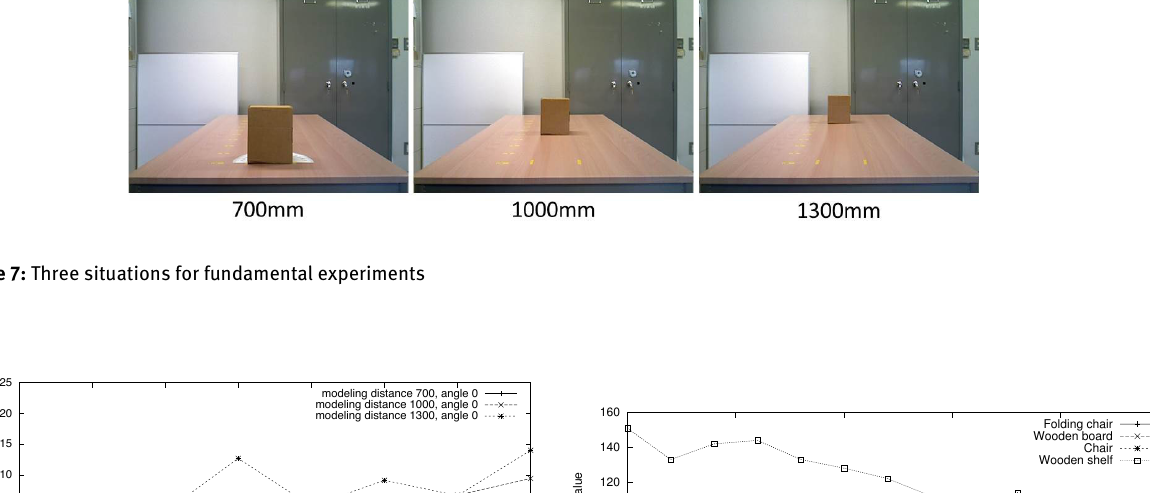
Figure 9: Distance vs. Evaluation value